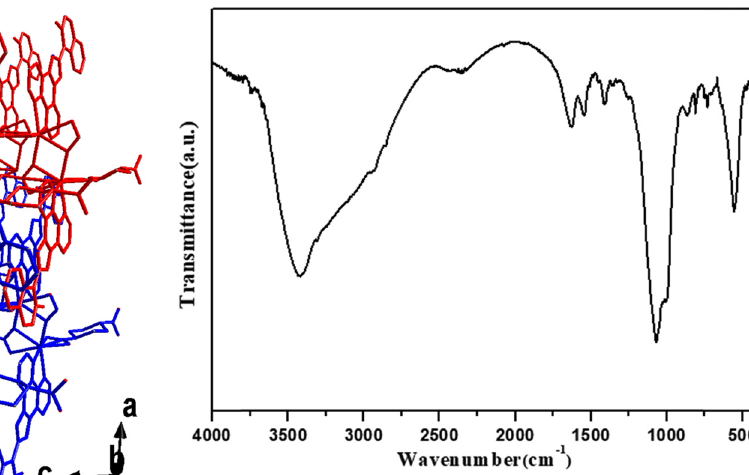
Figure 7: IR spectroscopy curve of 1